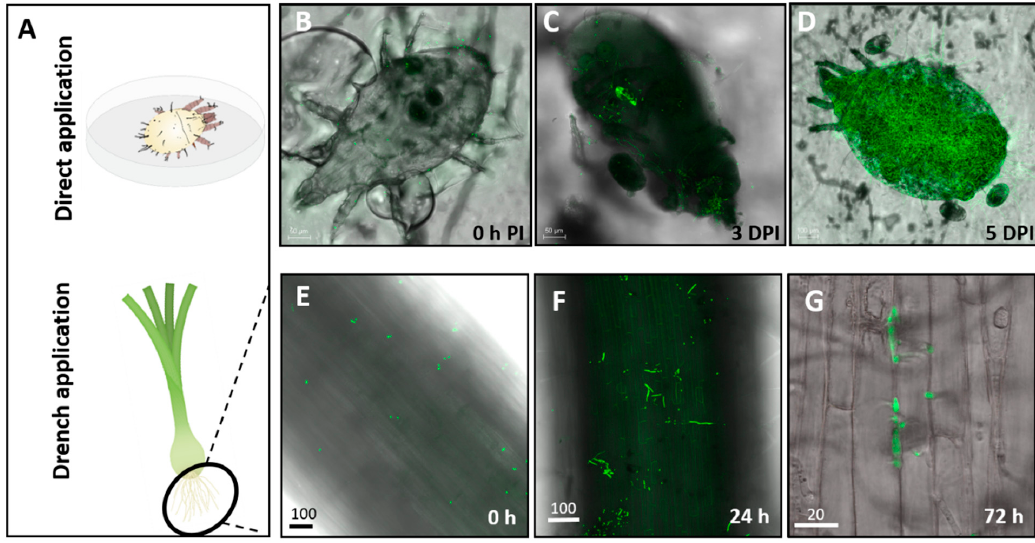
Figure 3. ( A ) Assessment of Mb7 effect on Rhizoglyphus robini mite survival in vitro in Petri dish and in-planta on onion bulblets. ( B - D ) Progression of Mb7 on adult R. robini mites after direct application by spraying of conidia (10 7 conidia mL − 1 ). ( E – G ) Progression of root colonization by Mb7 after drench application to bulblets (10 7 conidia mL − 1 ). PI, post inoculation; DPI, days post inoculation.